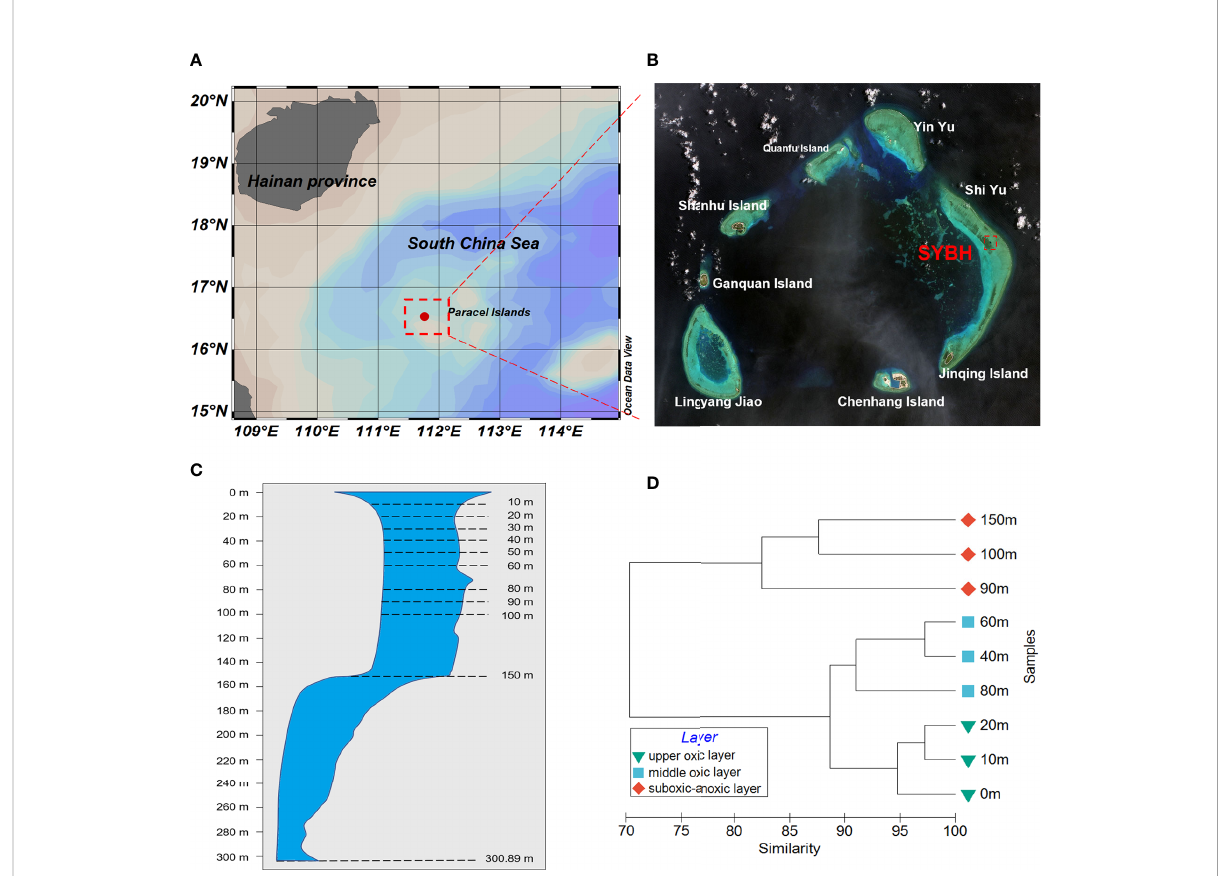
FIGURE 1 (A, B) Location of the Sansha Yongle Blue Hole (SYBH). (C) Vertical section through the SYBH and dash lines indicate the sampling depths in this study and the deepest depth of 300.89 m (modi fi ed from Li et al.,2018). (D) Vertical heterogeneity shown by the dendrogram of cluster analysis based on environmental variables at each depth in the